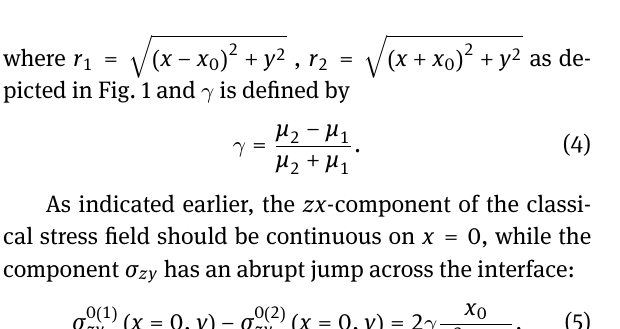
(cid:113) ( x + x 0 ) 2 + y 2 as de-